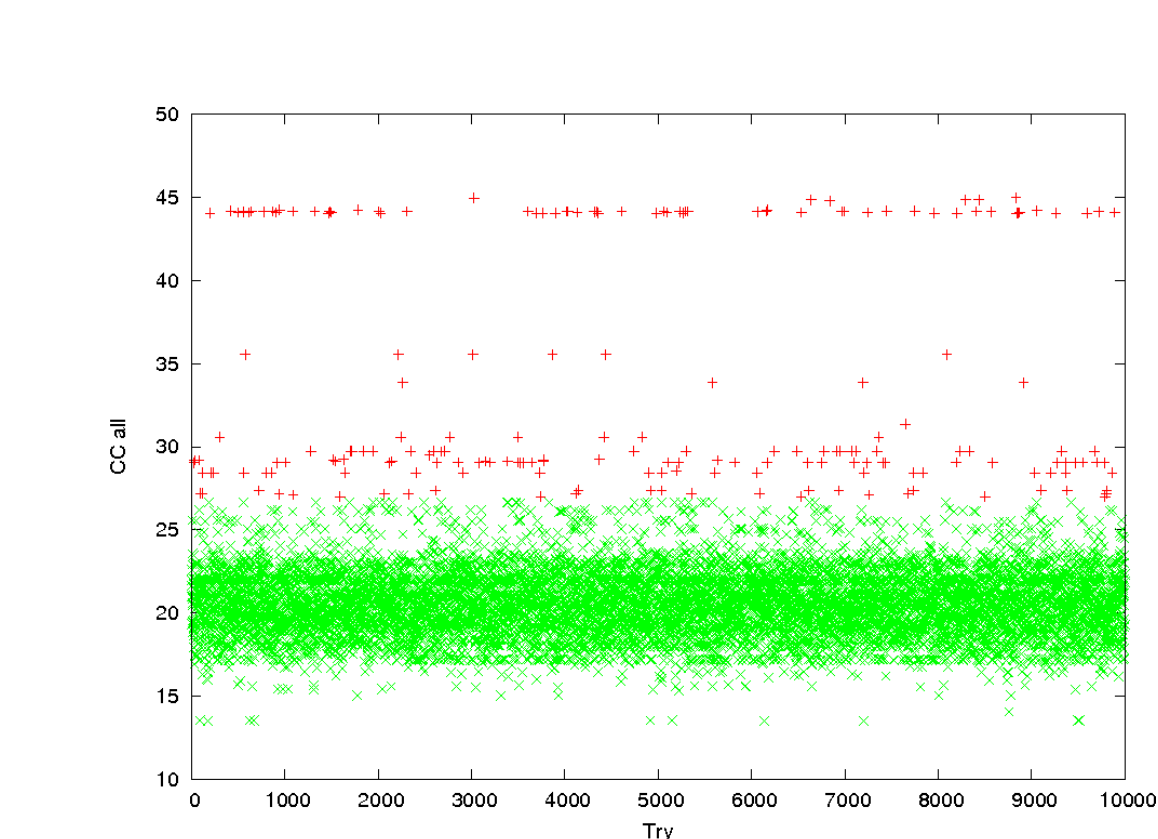
Figure 1. Scatter plot of correlation coefficient calculated for all data (CCall) calculated by SHELXD versus try number for